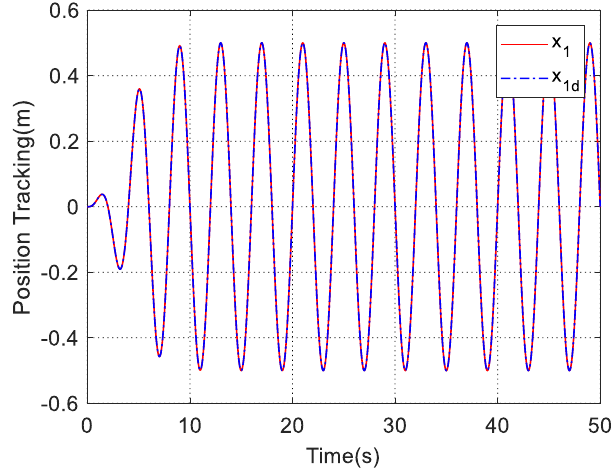
Figure 6. Tracking result of FOFA.